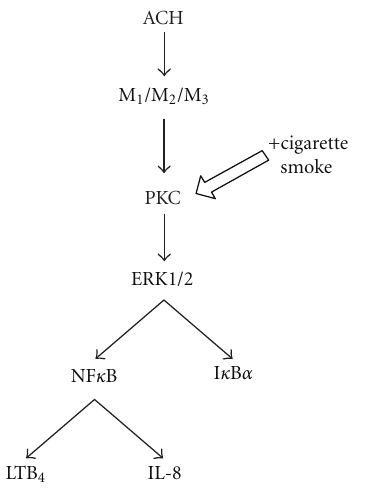
Figure 2: Synergistic e ff ects of acetylcholine (ACH) and cigarette smoke on M 1 , M 2 , and M 3 receptors. LTB4: leukotriene B4, PKC: protein kinase C, NF κ B: nuclear factor kappaB, and I κ B: inhibitor of NF κ